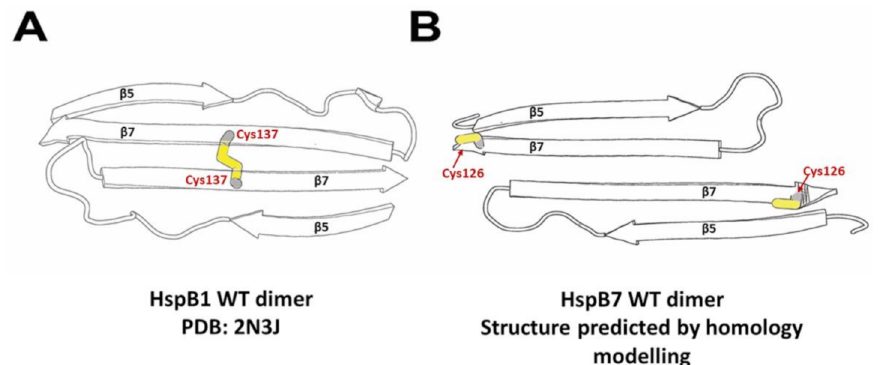
Figure 8. Diagram of ACD interface and cysteine location in two sHsps. ( A ) HspB1-oxidized dimer PDB 2N3J. ( B ) Model of HspB7 homodimer constructed by the SWISS-MODEL server with PDB 4JUS as a template. Only β 5 and β 7 strands of sHsps monomers are